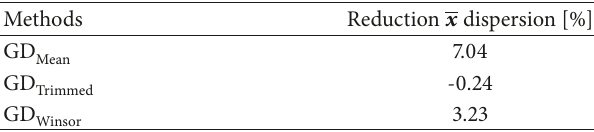
Table 33: Exponential with 1000